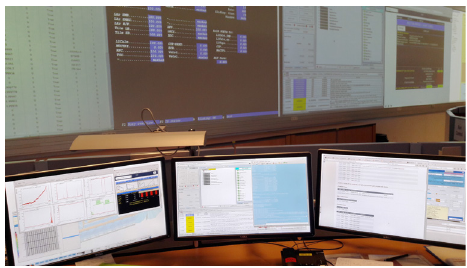
Figure 1. View of a shifter working environment in ATLAS Control Room